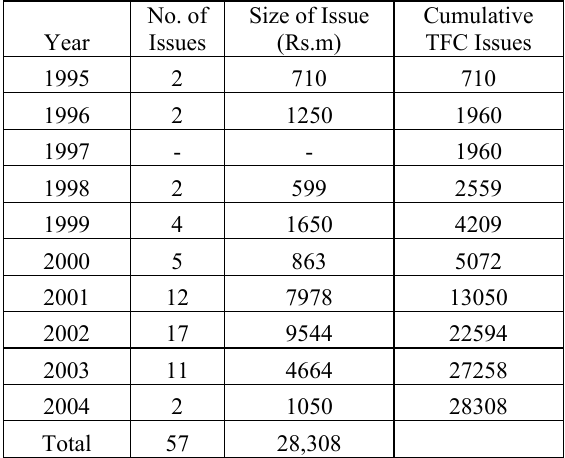
Table 3. TFC Issues by the Corporate